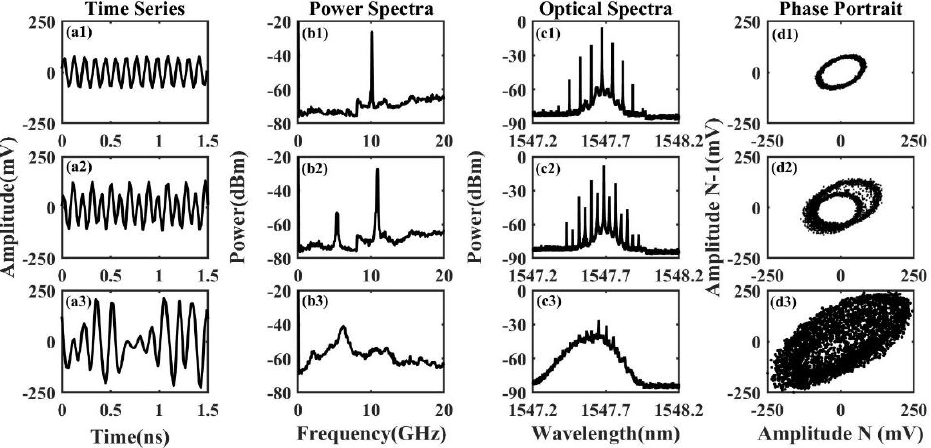
Figure 2. ( a ) Time series, ( b ) power spectra, ( c ) optical spectra, and ( d ) phase portraits of the DM laser output when Δ f is 10 GHz and ξ inj is 0.06 (row 1), 0.36 (row 2), and 0.56 (row 3).